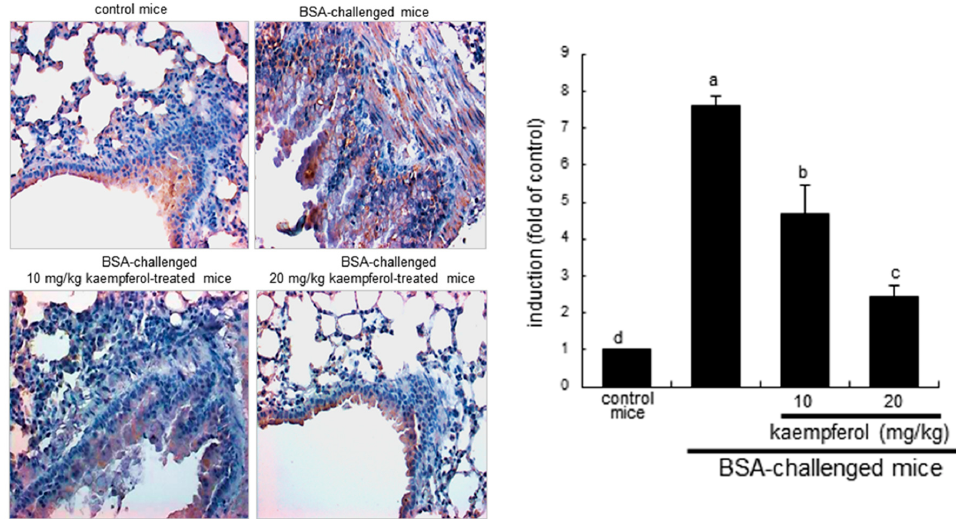
Figure 3. Immunohistochemical analysis showing inhibition of COX2 induction in BSA-challenged mouse airway tissues by kaempferol. BSA-sensitized mice on days zero and 14 were challenged with 5% BSA on days 28, 29, and 30. Airway tissue COX2 was visualized by staining with 3,3 ′ -diaminobenzidine and counterstained by using hematoxylin. COX2 was identified as dark brown color and quantified by using an Axiomager optical microscope system ( right panel). Each photograph is representative of four mice. Magnification: 200-fold. Bar graph values (mean ± SEM, n = 4) without a common letter differ, p < 0.05.